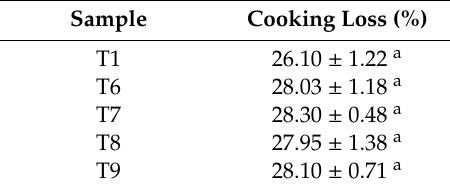
Table 8. Cooking loss (%) of beef patty cooking in di ff erent